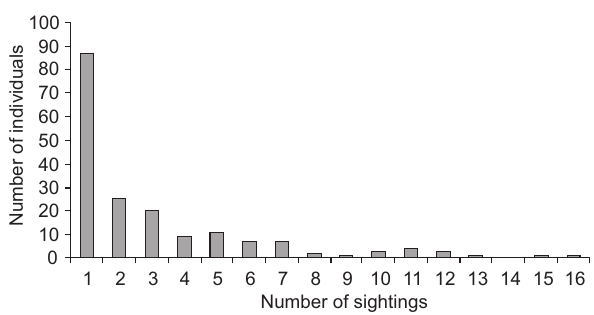
Figure 7. Frequency of sightings of S. guianensis photo-identified in seven distinct seasons in the Paranaguá Estuarine Complex, Brazil, between April 2006 and July